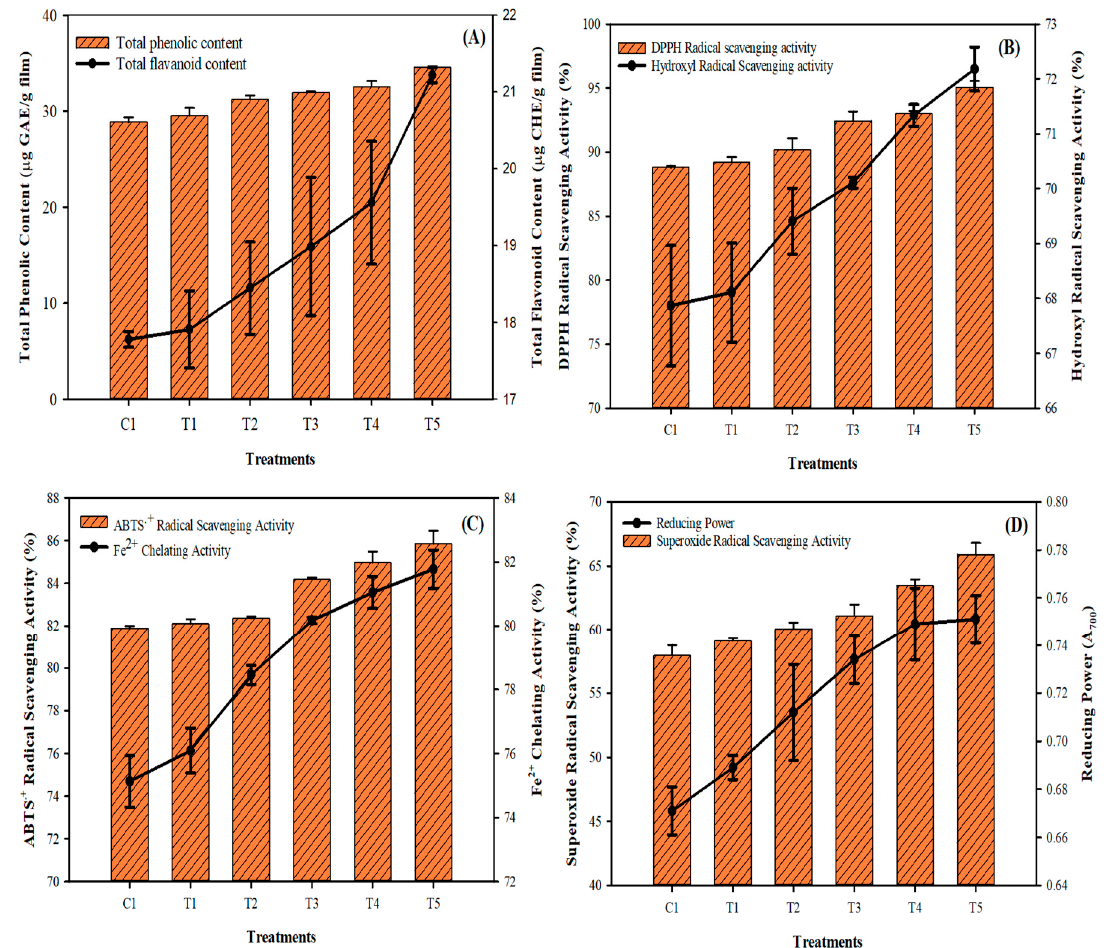
Figure 4. Phytochemical ( A ) and radical scavenging abilities ( B – D ) of the mung bean phyto-film that incorporated LPE and was processed under sonication.